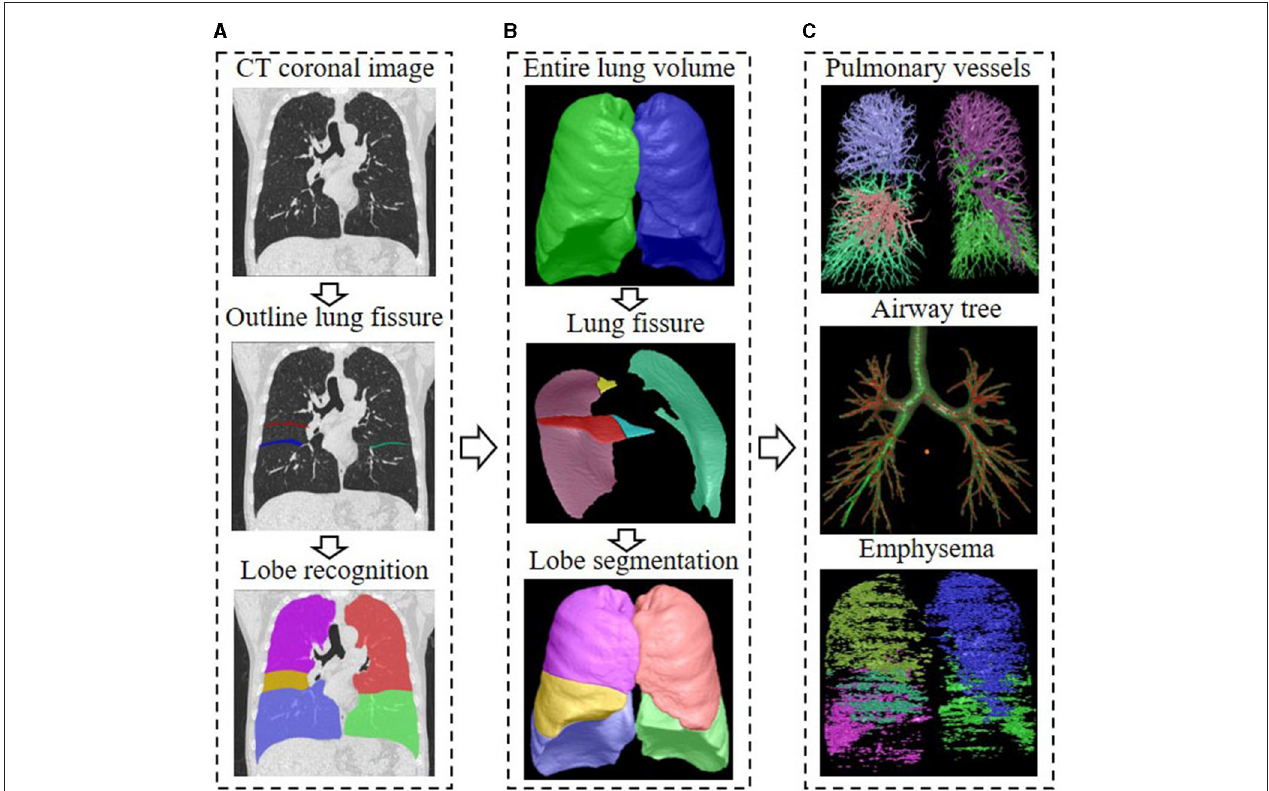
FIGURE 1 | Flow chart of CT quantitative parameter measurement. (A) The delineation of lung fissures and the identification of lung lobes on CT images; (B) The total lung volume identified by the 3D adaptive border marching algorithm, the lung fissure segmented by the computational geometry approach, and the five lung lobes segmented by implicit surface functions; (C) The principal curvatures and the principal directions were used to distinguish pulmonary vessels from lung tissue, and the vascular tree was automatically extracted and segmented to calculate IPVV in the whole lung and each individual lobe; The differential geometric approach to segment the airway tree, and the average values of the measurements for the 3–6th bronchial generation were automatically calculated; The extent of emphysema under the threshold of − 950 HU was automatically computed, the area shown in